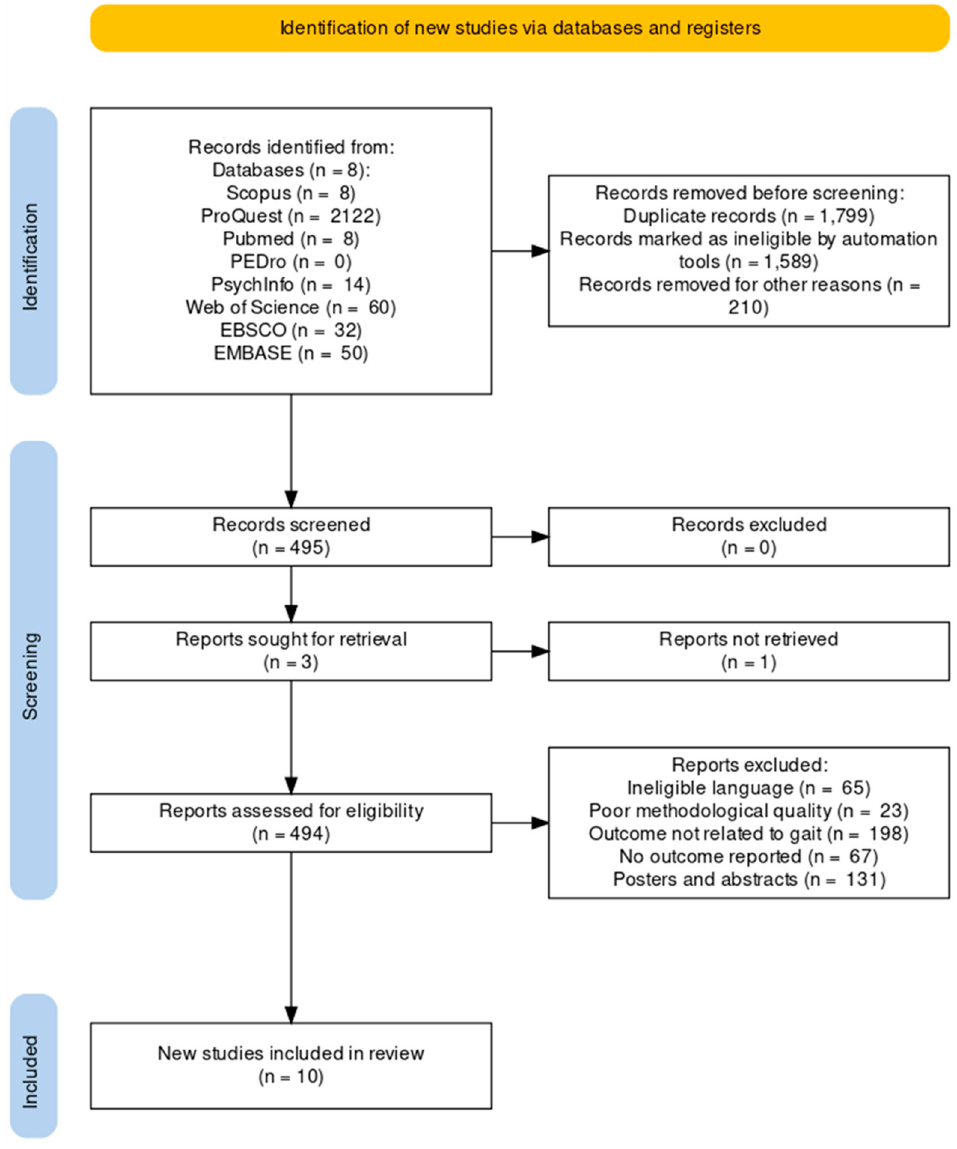
Figure 1. PRISMA fl owchart.